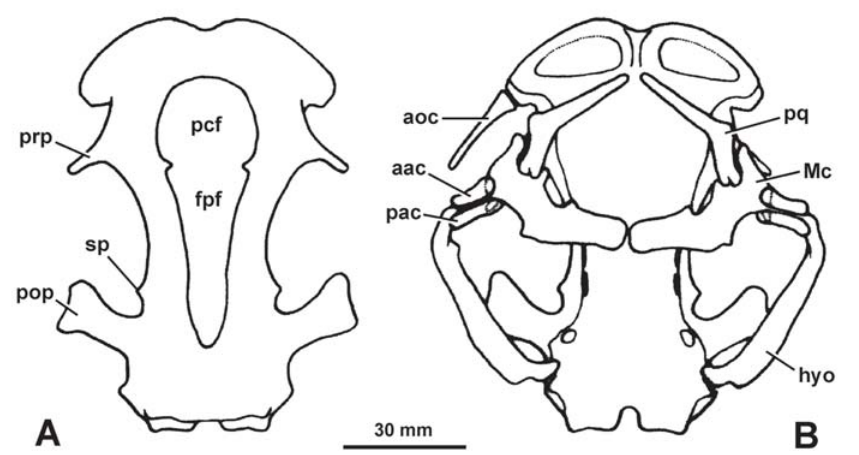
Fig. 8. Potamotrygon boesemani . ( A ) Dorsal view of neurocranium. ( B ) Ventral view of neurocranium and jaws, traced from radiograph (Meckel’s cartilage and palatoquadrate somewhat distorted by opened mouth) (USNM 225574, 377 mm DW). Note that antorbital cartilage has been removed from left side in B . Abbreviations: aac =anterior angular cartilage, aoc =antorbital cartilage, fpf =frontoparietal fontanelle, hyo =hyomandibula, Mc =Meckel’s cartilage, pac =posterior angular cartilage, pcf =precerebral fontanelle, pop =postorbital process, pq =palatoquadrate, prp =preorbital process, sp =supraorbital